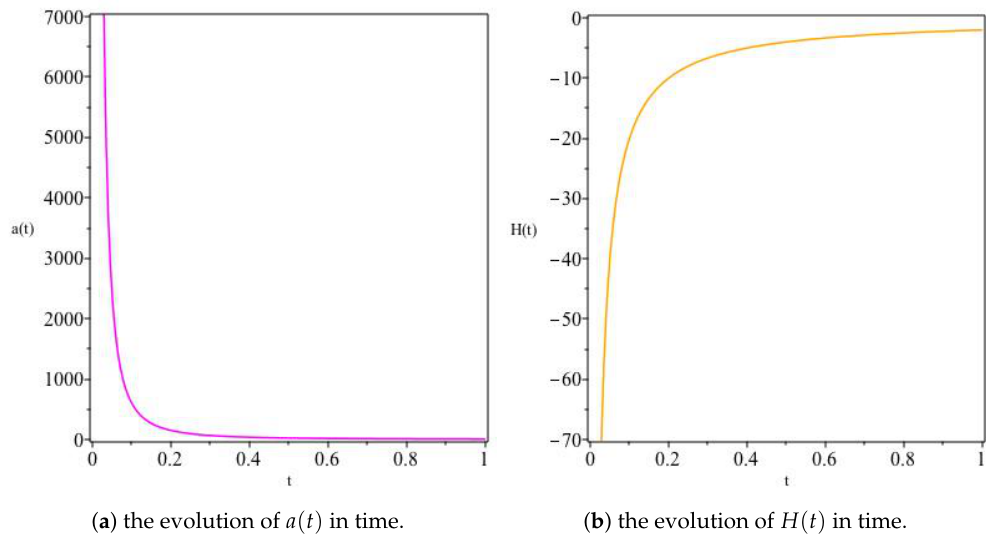
Figure 10. The variation of a and H for Model II. This model depicts a contracting universe (Panel ( a )) for a particular set of parameters ( α = γ = 1 , β = 3.5, for example). Panel ( b ) shows that contraction occurs at a decreasing rate, asymptotically leading to a universe with vanishingly small constant size at late times.